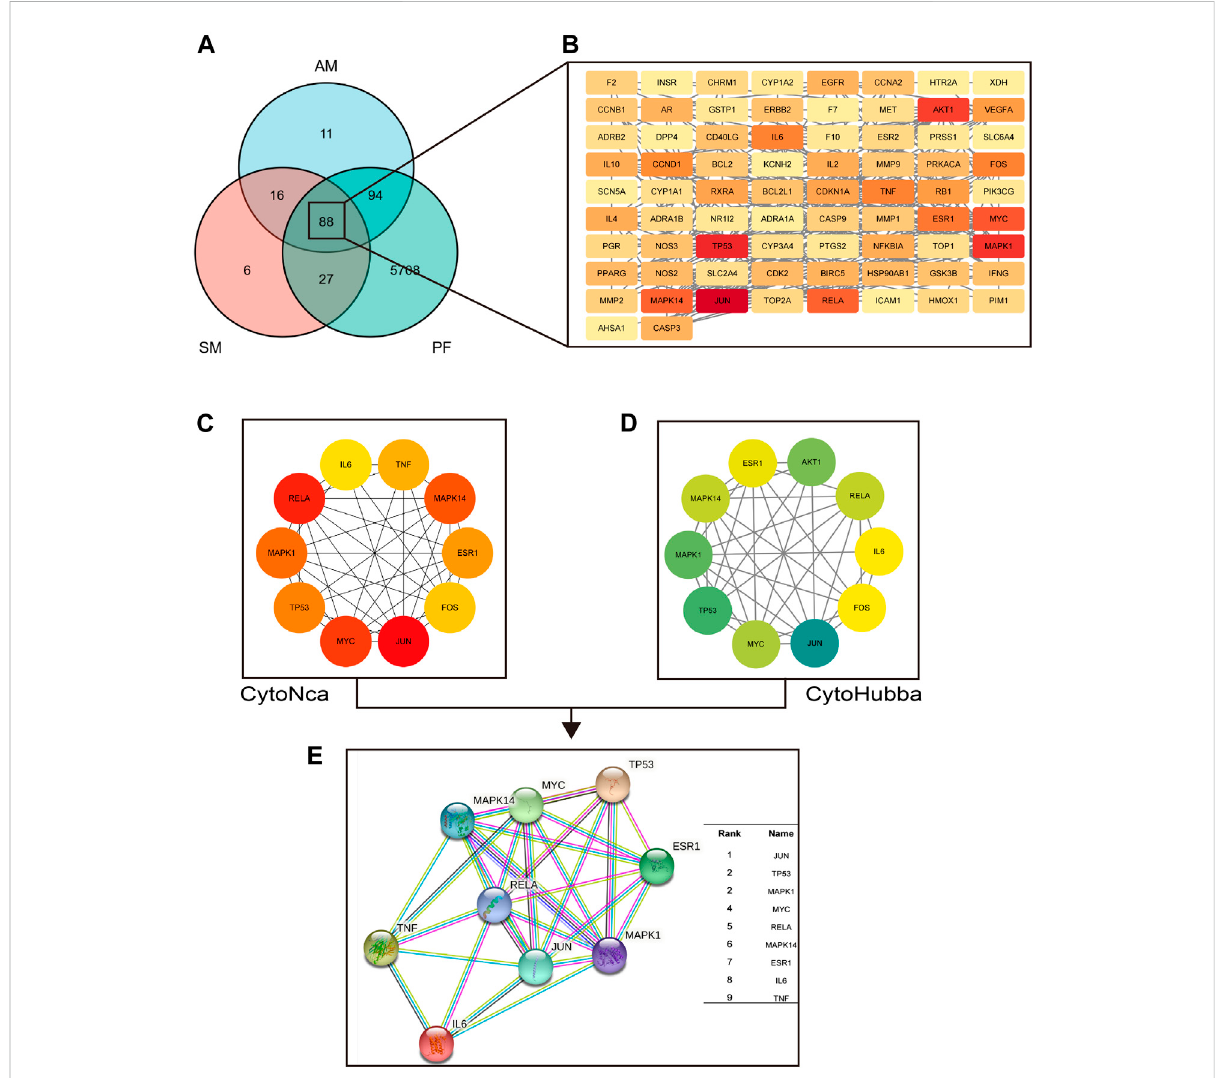
FIGURE 5 ThehubtargetproteinsofYHDintreatingPFscreenedbynetworkpharmacology. (A – B) thecommontargetproteinsbetweenYHDandPF.Red nodes represent critical target proteins. (C) the top 10 target proteins screened by CytoNca algorithms. (D) the top 10 target proteins screened by CytoHubba algorithms. (E) the nine most critical target proteins obtained from the intersection. Two different algorithms screened target proteins, and the intersection was taken to obtain the most critical target